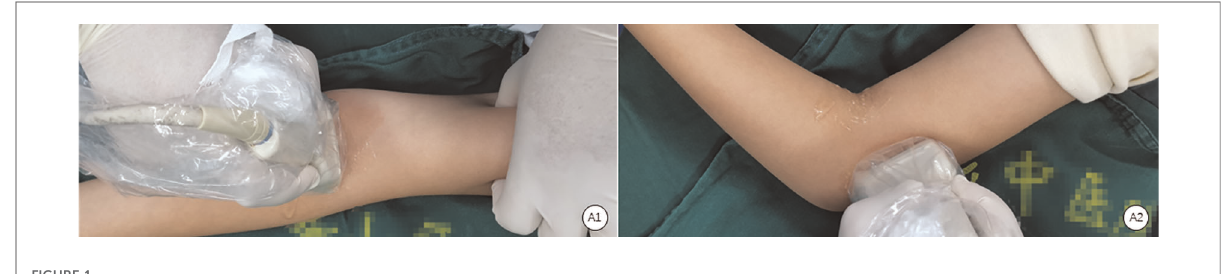
FIGURE 1 ( A1 ) The transverse plane. ( A2 ) The coronal